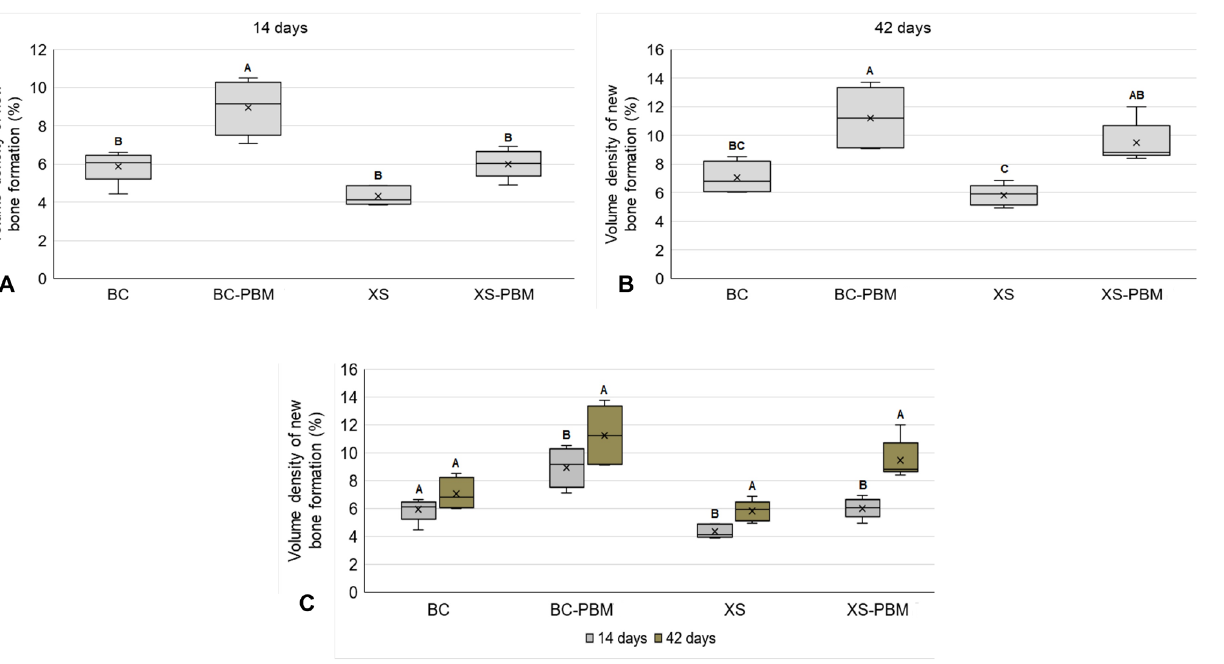
Figure 7. Volume density of new bone formed (%) in the different groups tested (BC, BC-PBM, XS, XS-PBM) in the periods of (A) 14 and (B) 42 days; ANOVA followed by Tukey’s post-test ( p ≤ 0.05). (C) Volume density of new bone formed (%) in each group tested in the evaluated periods (14 and 42 days); Student’s t test ( p ≤ 0.05). Different letters (A ≠ B ≠ C) indicate a significant difference ( p ≤ 0.05).